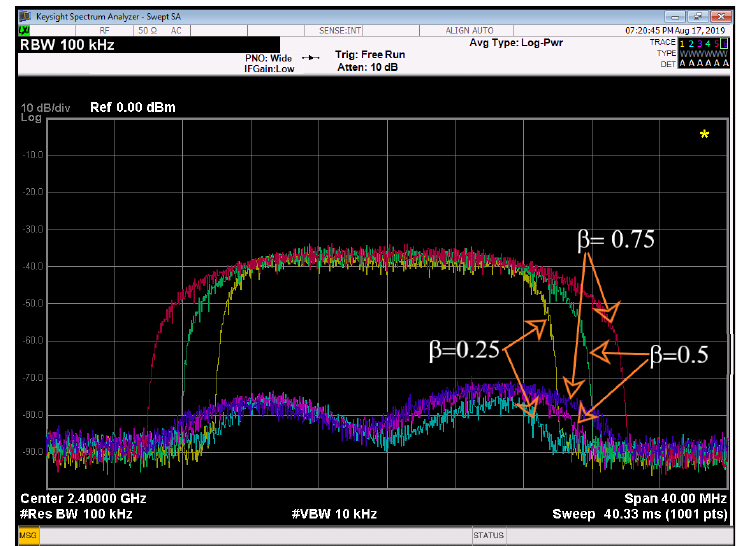
Figure 9. Cancellation performances with different roll-off factors.